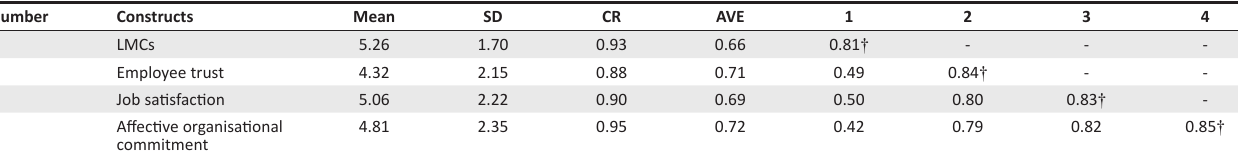
TABLE 2: Descriptive statistics and inter-construct correlations ( n =